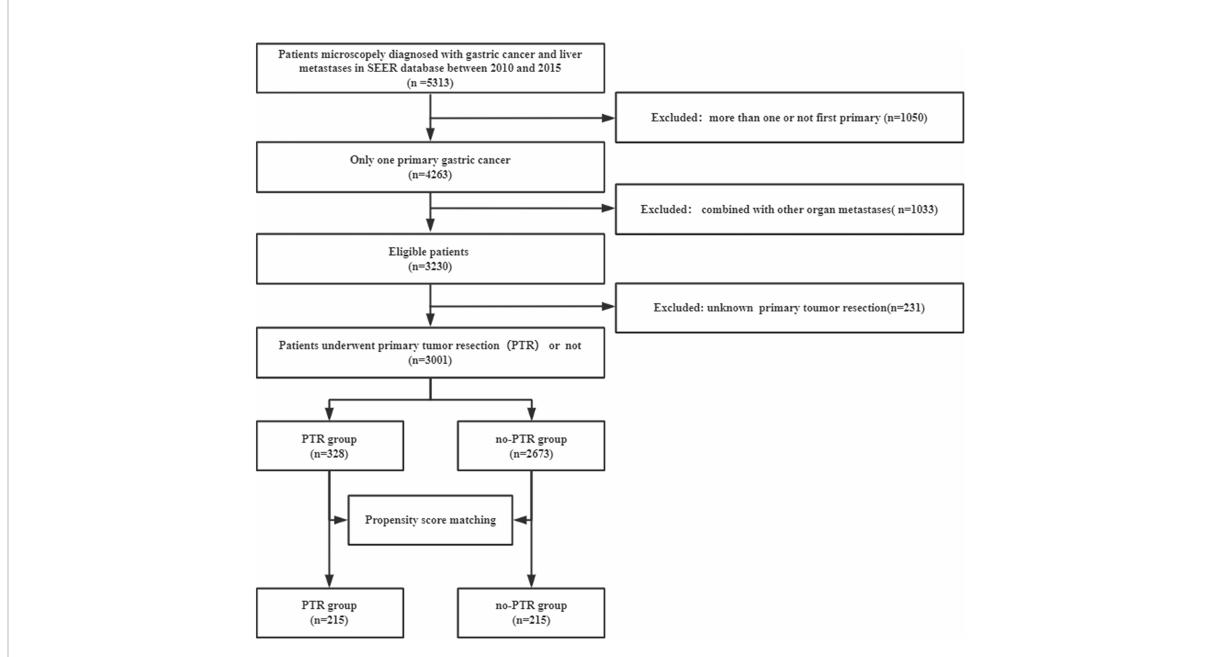
FIGURE 1 Flowchart of patient